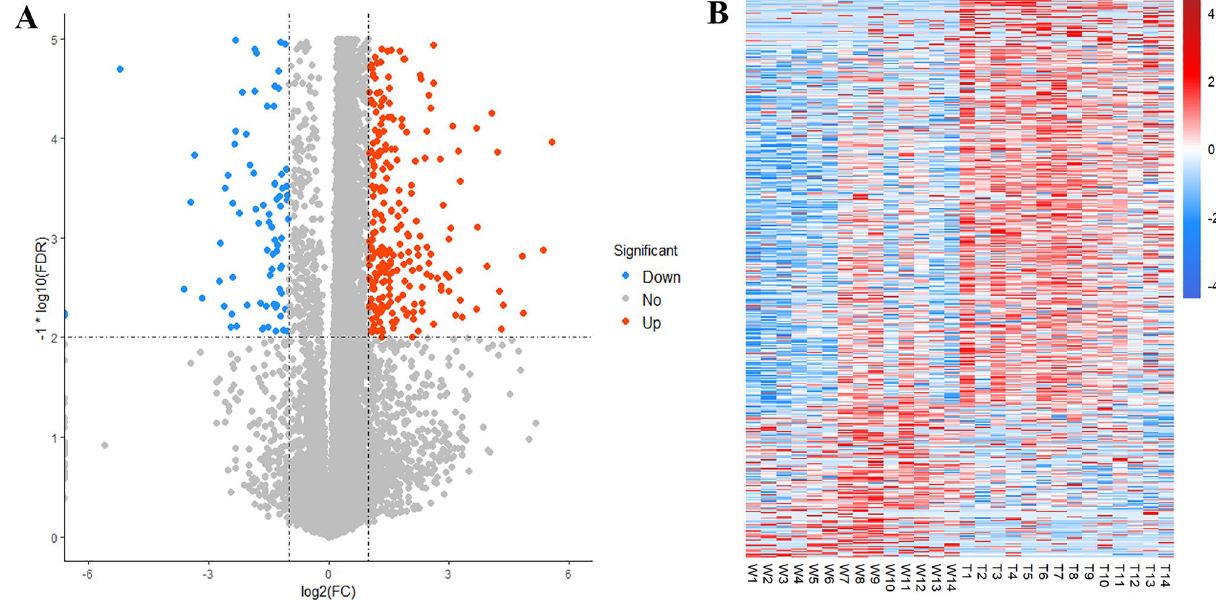
Figure 2. The differentially expressed genes between WT and DB mice. ( A ) The volcano plot of DEGs between two groups. ( B ) The heatmap displays expression levels of 689 DEGs based on the RNA-seq